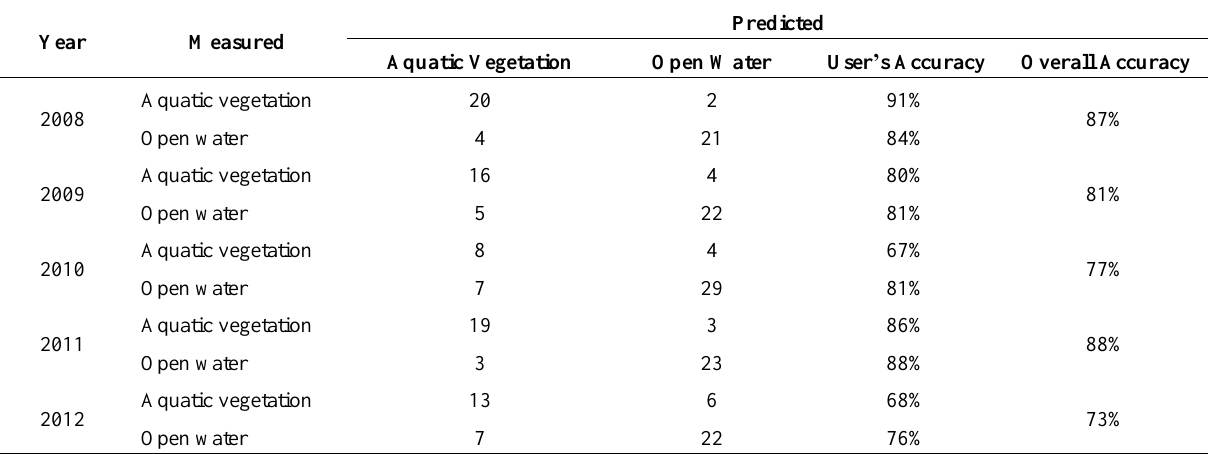
Table 3. Accuracy assessment of classification results from